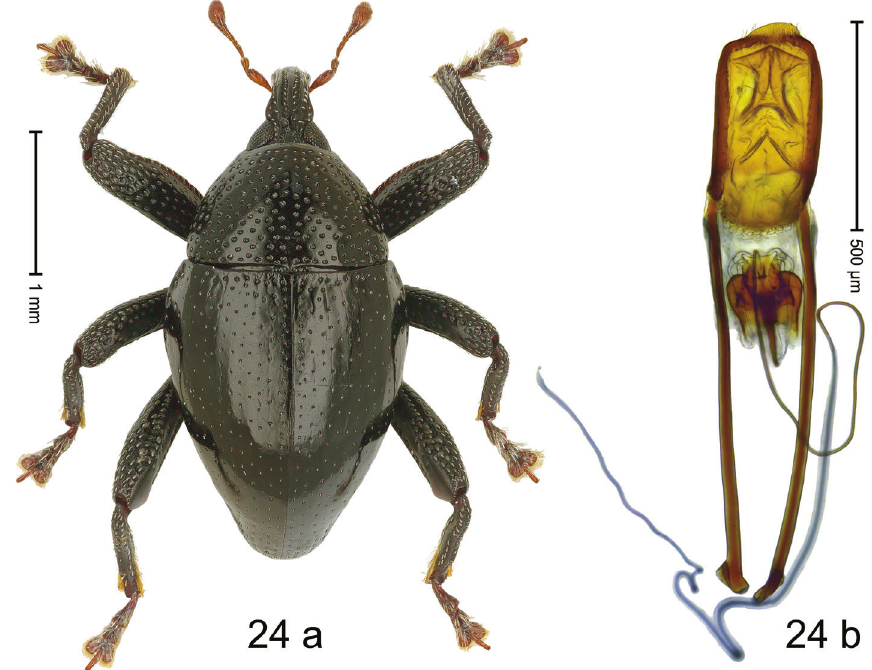
Figure 24. Trigonopterus tejokusumoi sp. nov., holotype a habitus b penis.